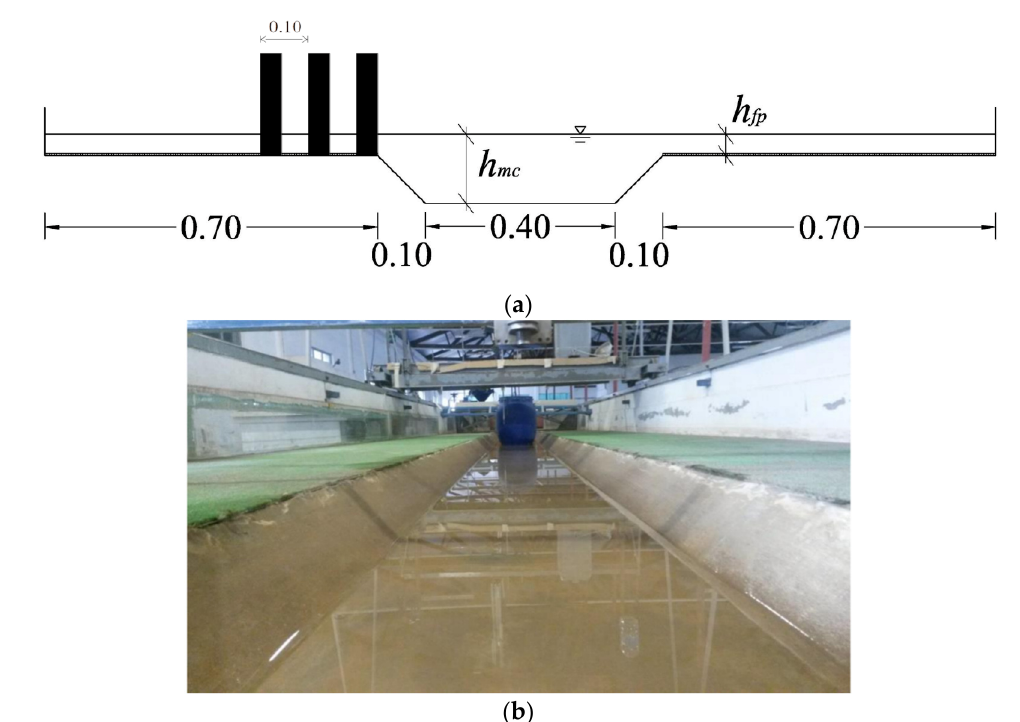
Figure 2. ( a ) Channel cross-section. Units are expressed in metres; ( b ) view from downstream to